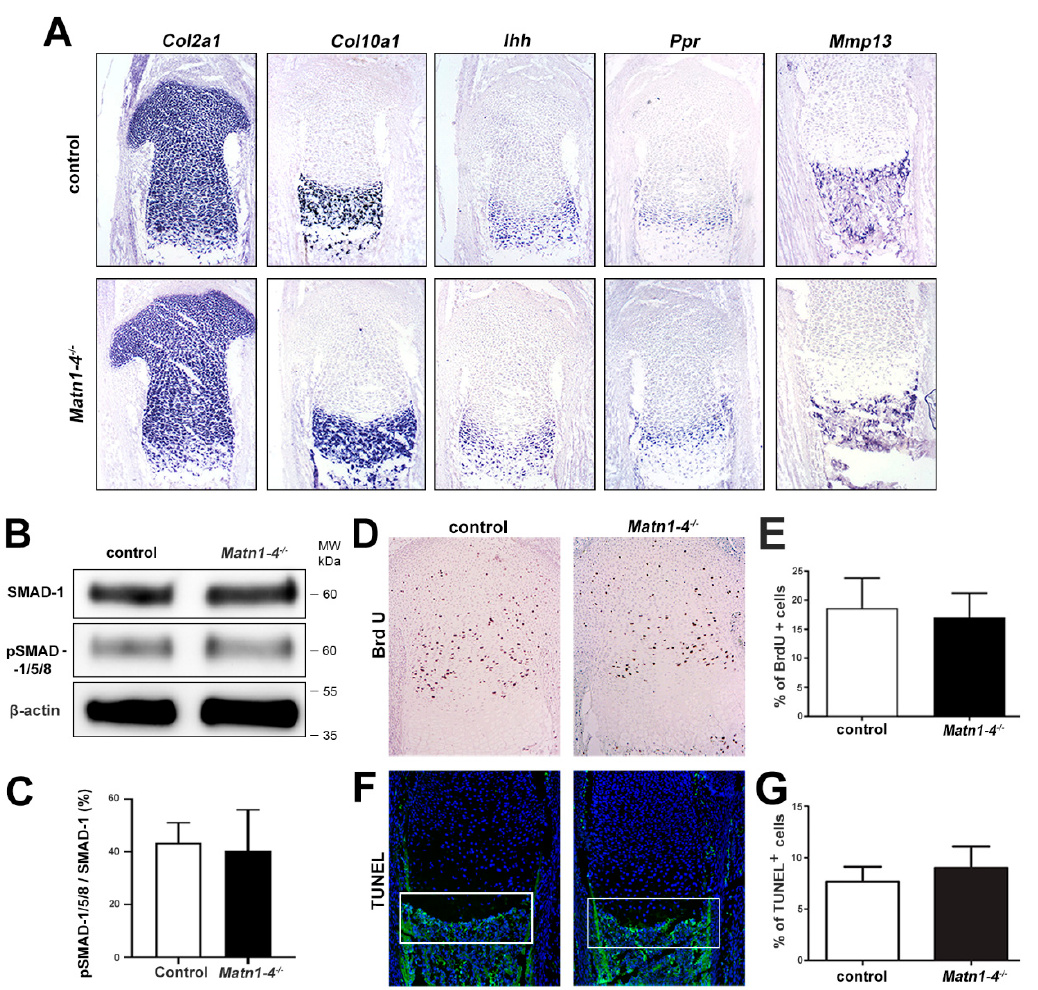
Figure 4. Chondrocyte differentiation, proliferation and apoptosis are not altered in Matn1-4 − / − mice. ( A ) Non-radioactive in situ hybridization for collagen II ( Col2a1 ), collagen X ( Col10a1 ), indian hedgehog ( Ihh ), PTH/PTHrP receptor ( Ppr ) and matrix metalloproteinase-13 ( Mmp13 ) show similar expression pattern in newborn control and mutant mice. Western blotting ( B ) and densitometric quantification ( C ) indicate normal activation of SMAD-1/5/8 in mutant primary chondrocytes. ( D ) BrdU incorporation assay and quantification ( E ) at the newborn stage indicate normal chondrocyte proliferation in the Matn1-4 − / − growth plate. TUNEL staining ( F ) and quantification ( G ) do not reveal any difference in cell death at the chondro-osseous junctions (white boxes) in newborn control and Matn1-4 − / − mice. Abbreviation: MW-molecular weight marker. Original magnifications: ×10 for ( A ), ( D ) and ( F ).